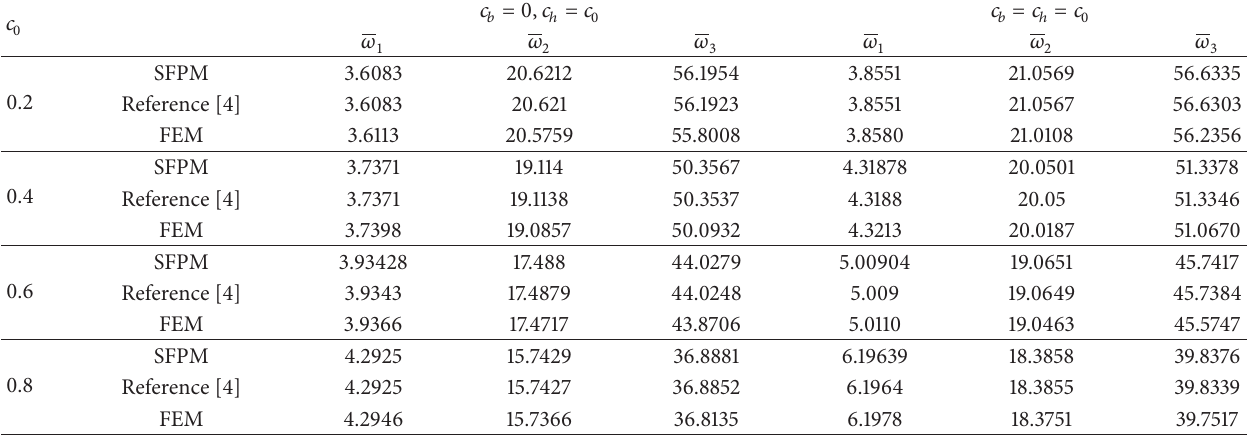
Table 3: Nondimensional transverse natural frequencies 𝜔 𝑖 for tapered homogenous beam; boundary condition: C-F. 𝑐 0